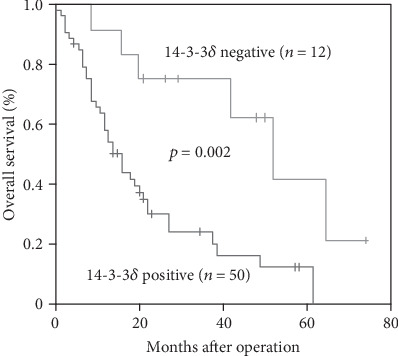
The 14-3-3δ expression is correlated with extrahepatic CCA patients' survival. Patients were classified as positive 14-3-3δ group (n = 50) and negative group (n = 12). Data were generated using the Kaplan–Meier method. The statistical significance of differences in the survival analyses were calculated using the log-rank test. P = 0.002.